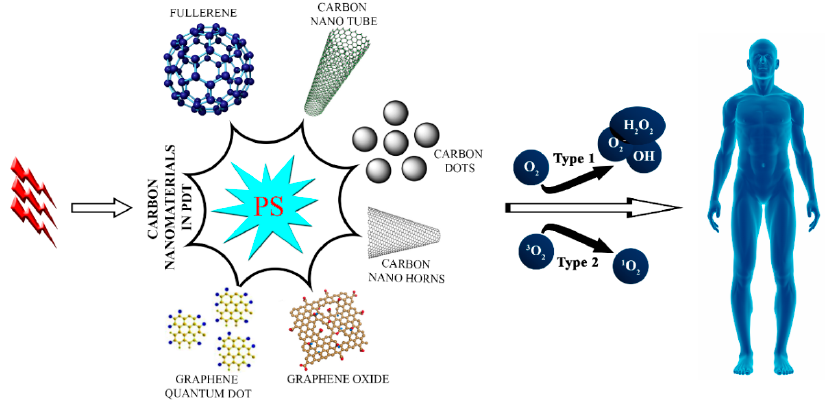
Figure 1. Schematic illustration of the photodynamic application of carbon-based